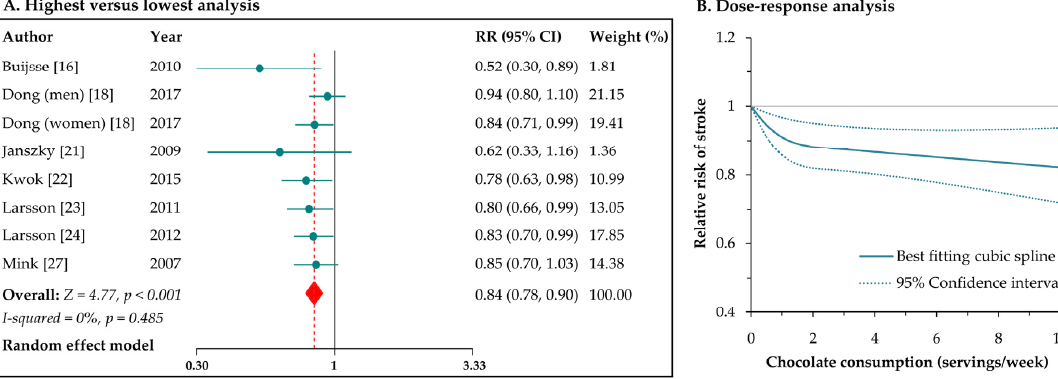
Figure 3. Meta ‐ analyses of chocolate consumption and risk of stroke. Figure 3. Meta-analyses of chocolate consumption and risk of